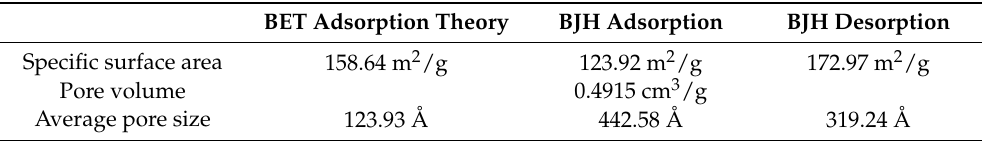
Table 2. BET and BJH analyses of specific surface area, pore volume, and average pore size for the prepared HAp–gelatin microspheres.